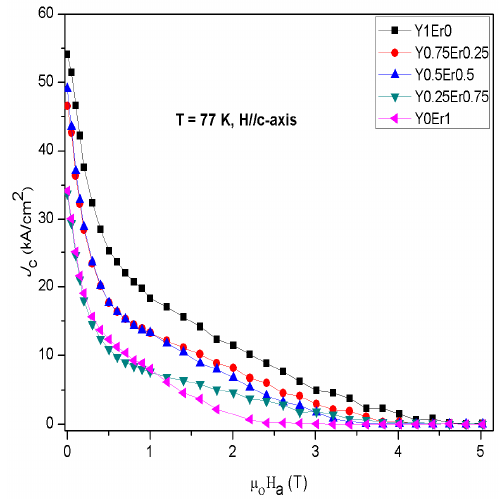
Figure 8. Measured J c -H characteristics at 77 K at self-field of samples with various amount of LP 281 ratios (Y123:Er123). 282